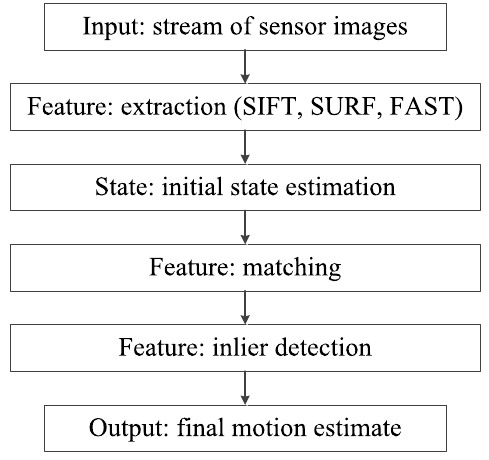
Figure 11. Local state estimation process.